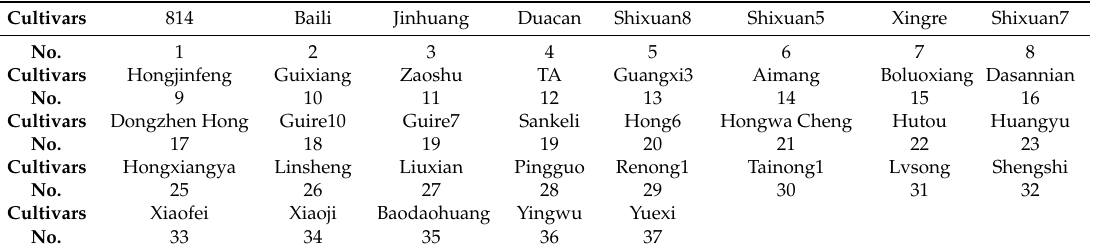
Table 9. 37 cultivars used in this study. The number following the cultivars indicates the sampling order. Cultivars